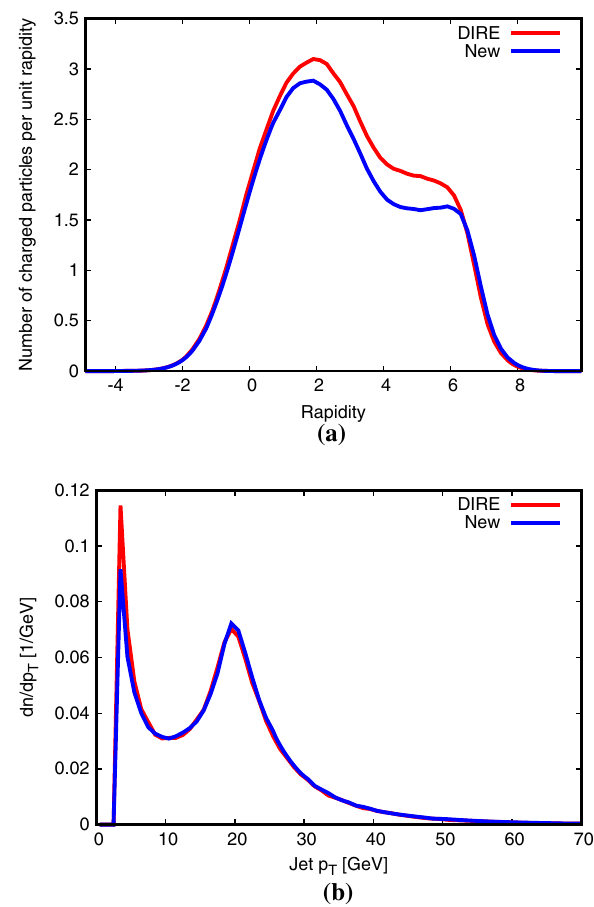
Fig. 17 Comparison between the new approach and the Dire shower, HERA ep collisions with beam energies 27.5 and 920 GeV and Q 2 > 400GeV 2 : a charged rapidity spectrum and b jet p ⊥ spectrum using the anti- k ⊥ algorithm with R = 0 . 7 and p ⊥ min = 3 GeV